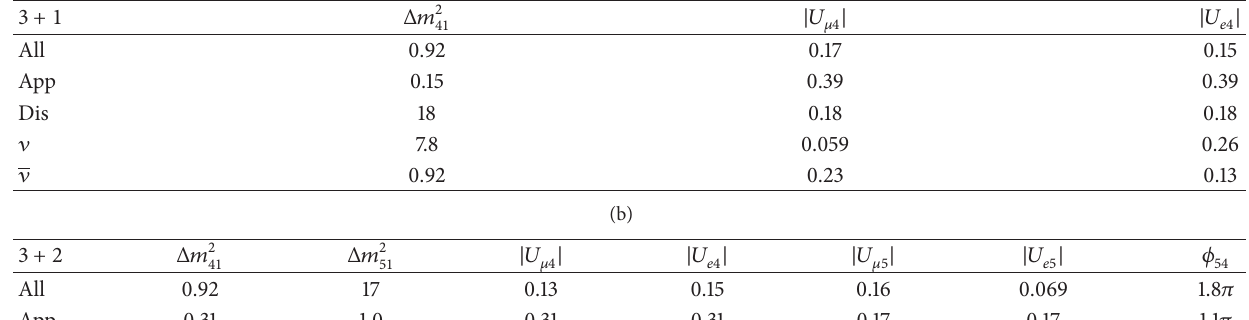
Table 3: The oscillation parameter best-fit points in each scenario considered. The values of Δ𝑚 2 shown are in units of eV 2 . (a)